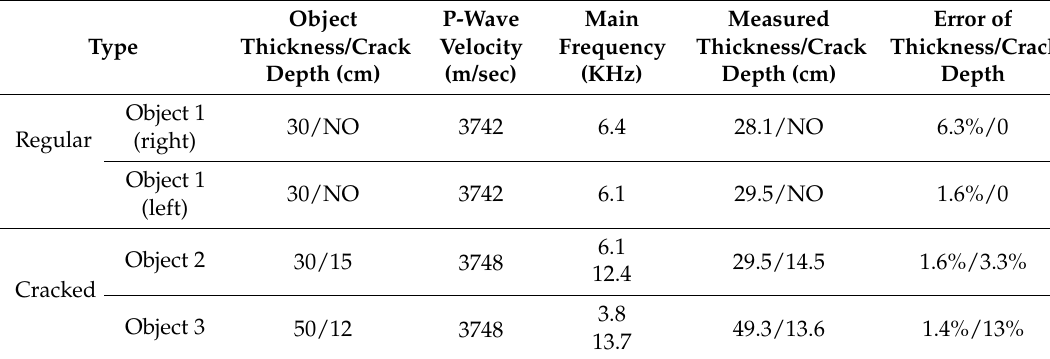
Table 2. Data of testing